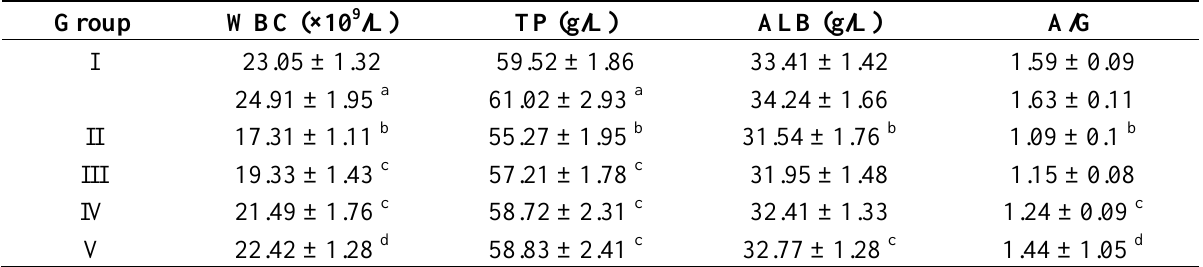
Table 4. Effect of tea polyphenol on serum white blood cells (WBC), total protein (TP), albumin (ALB) and